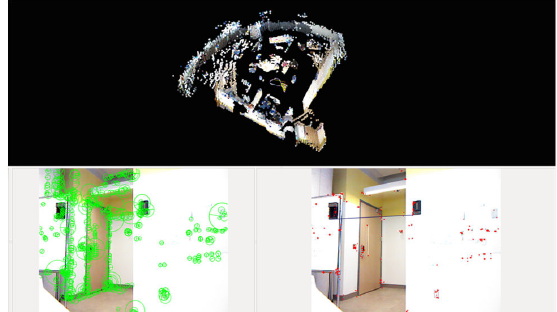
Figure 6. Screen capture of RGB-D SLAM. The top window shows the map (RGB point cloud) being created. The bottom right and left windows show the SIFT image feature (red dots) and their scales (green circles),